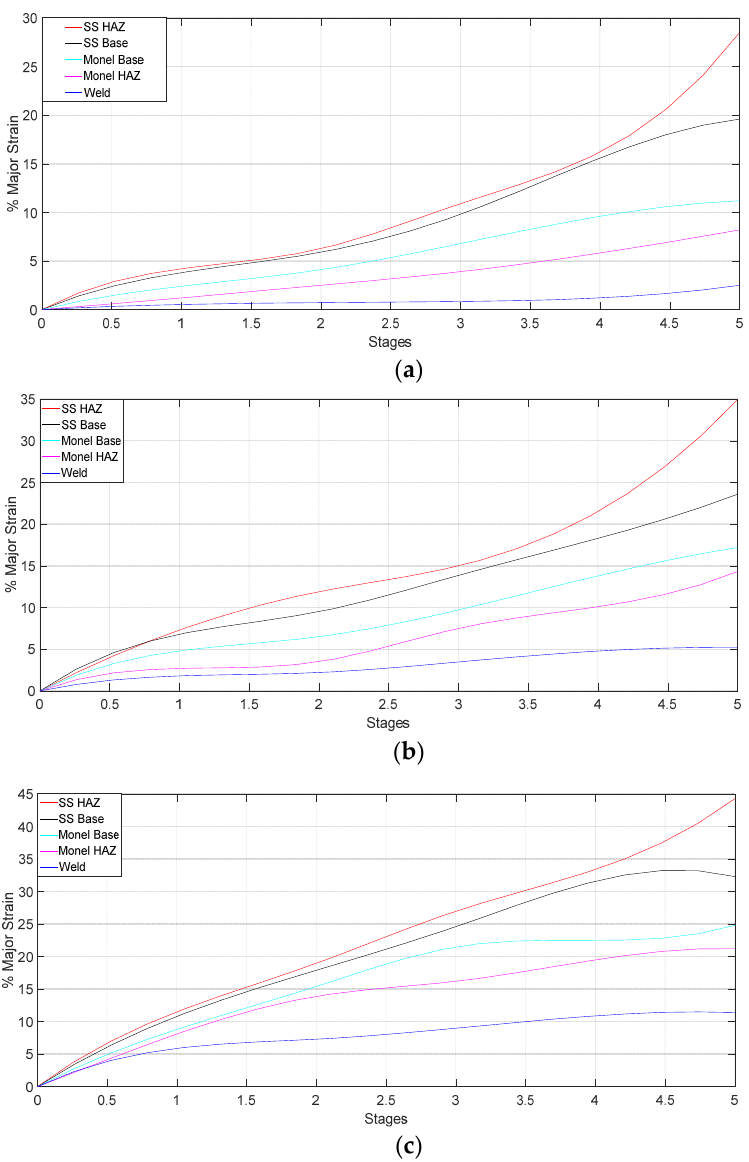
Figure 11. Variation of local strain at different regions of the weld: ( a ) UT specimen; ( b ) HT specimen; ( c ) CT specimen.